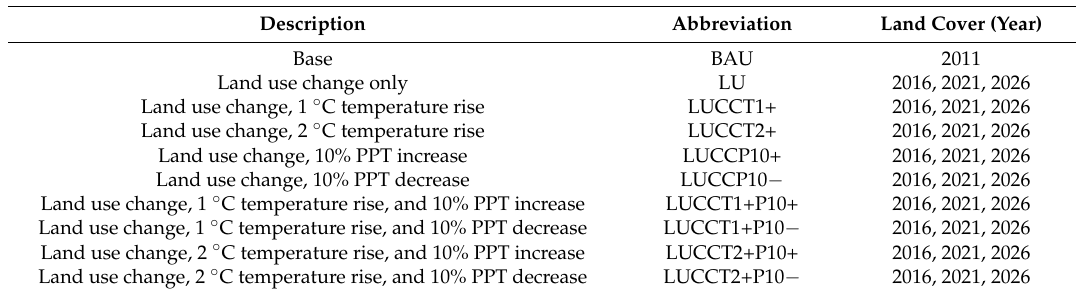
Table 4. Selected land use and climate change cases in this study. The base case is based on January 2001 to December 2014 climate with 2011 land use. PPT stands for precipitation.